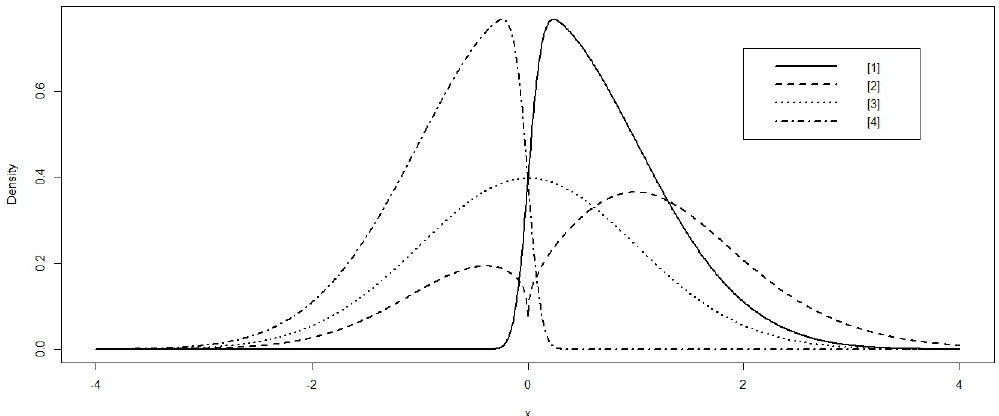
Figure 2. The Skew GL-Normal distribution using the following parameter values: [1] a = 1.59, b = 0.0727, p = 1.962 and c = 10; [2] a = 0.3, b = 0.7, p = 0.4 and c = 0.6; [3] a = 1.59, b = 0.0727, p = 1.962 and c = 0; [4] a = 1.59, b = 0.0727, p = 1.962 and c = −